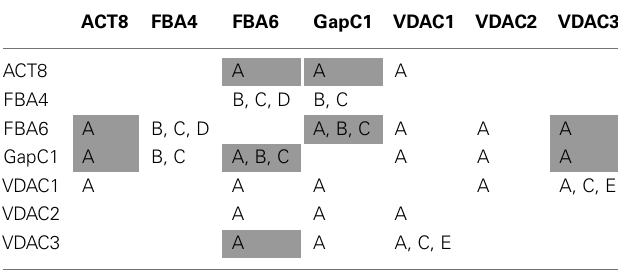
aldolase, GAPDH, actin